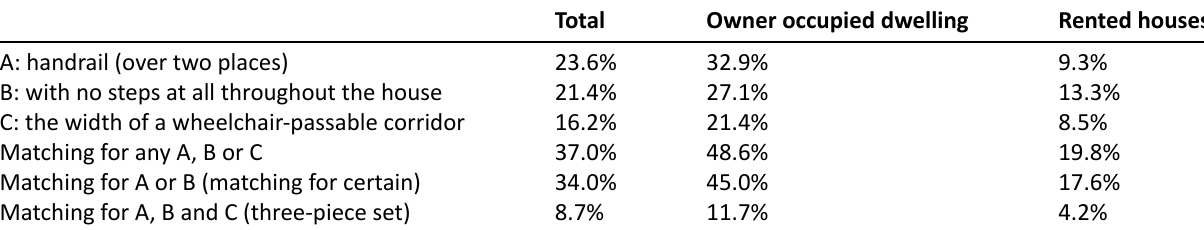
Table 4. Diffusion rate of barrier-free